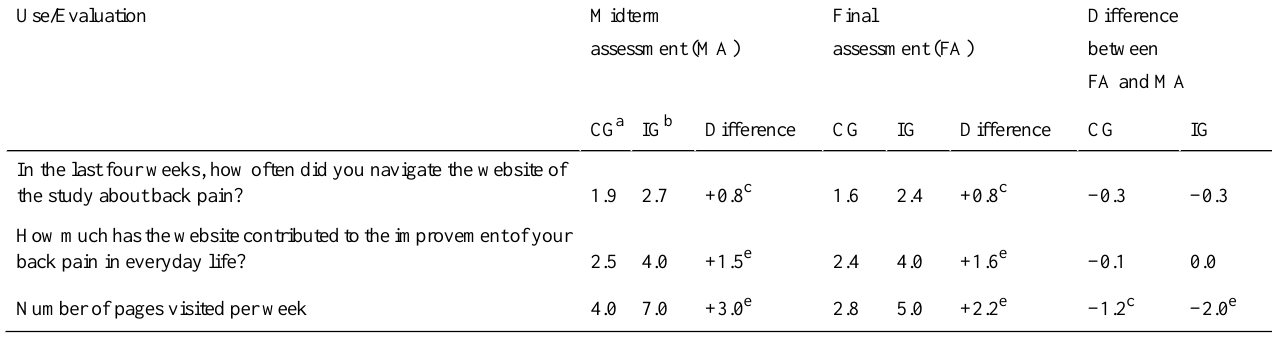
Table 3. Means and mean differences for use and evaluation of the website between two experimental